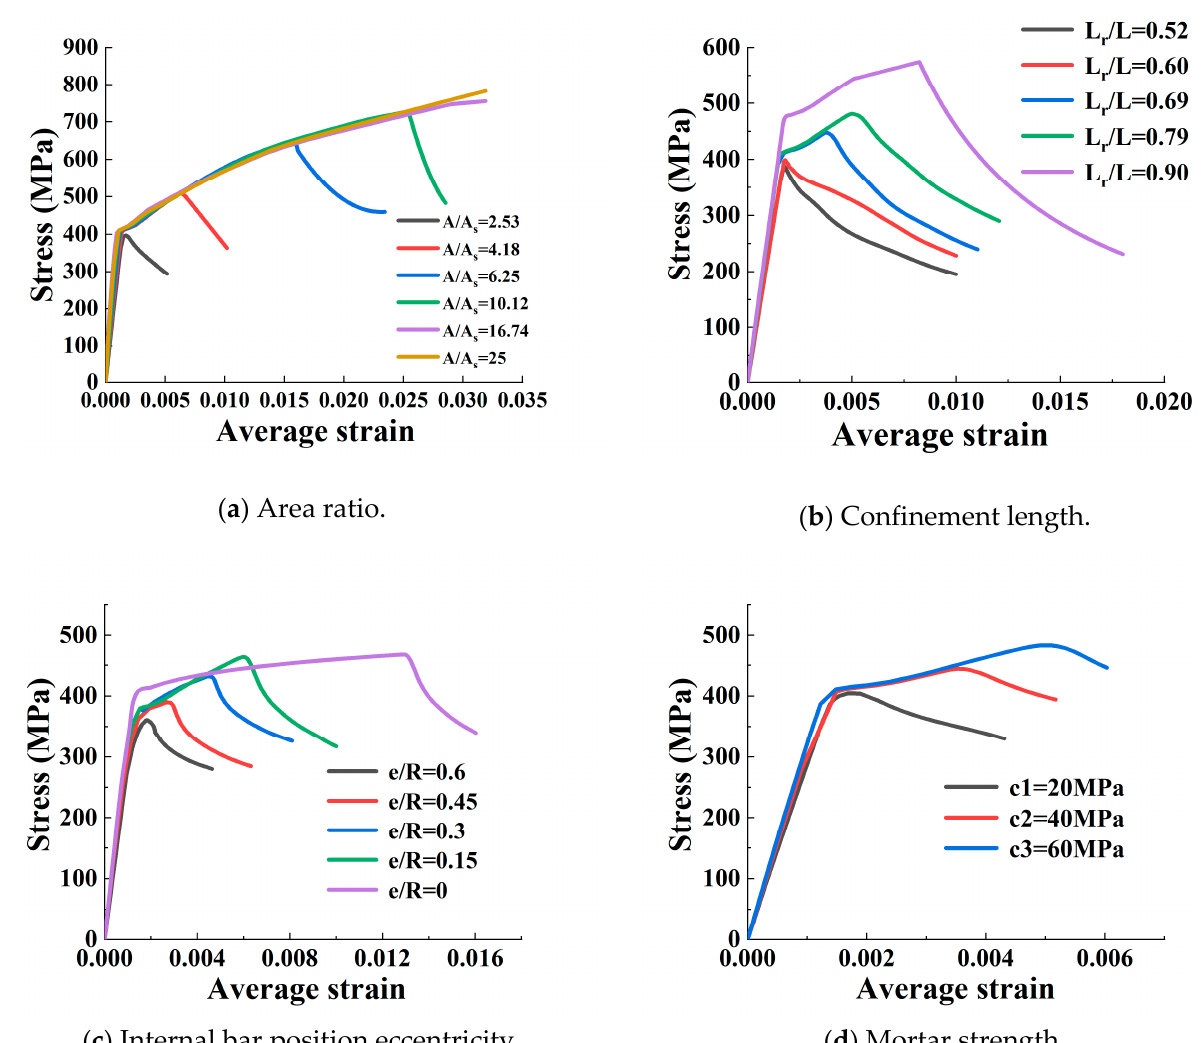
Figure 10. Effect of different parameters on the average stress–strain relationships under compres- sion.